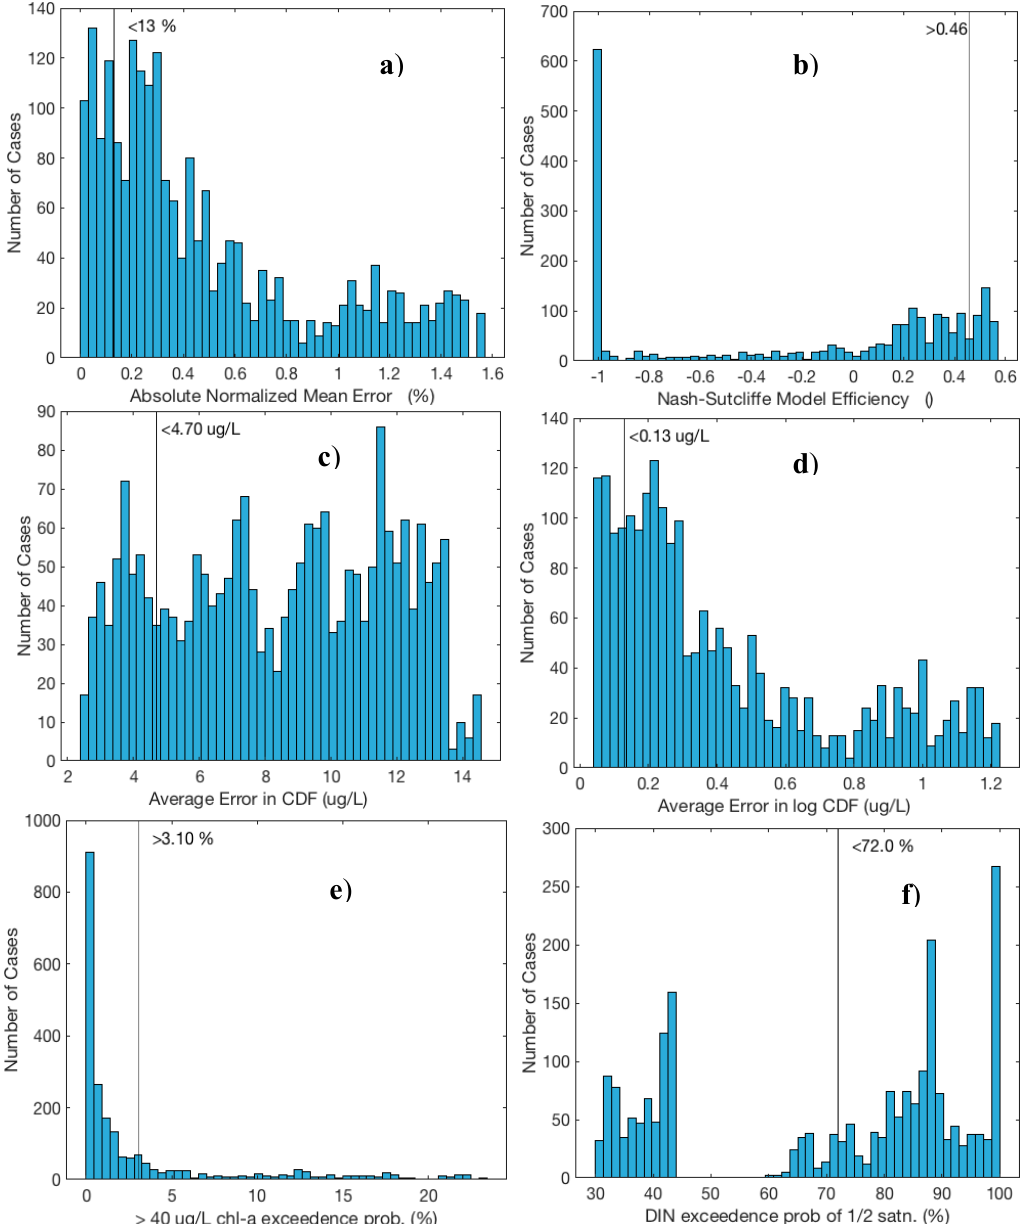
Figure 4. Histograms of calibration performance for the six criteria used to select model parameter sets (#1-5 used chl-a concentrations, #6 used DIN concentrations). The six criteria were: ( a ) absolute value of normalized mean model error (%); ( b ) Nash–Sutcliffe model efficiency; ( c ) average CDF error; ( d ) average log-transformed CDF error; ( e ) percentage of chl-a predictions above 40 ug/L; and ( f ) percentage of DIN concentrations above N ½ saturation constant for growth